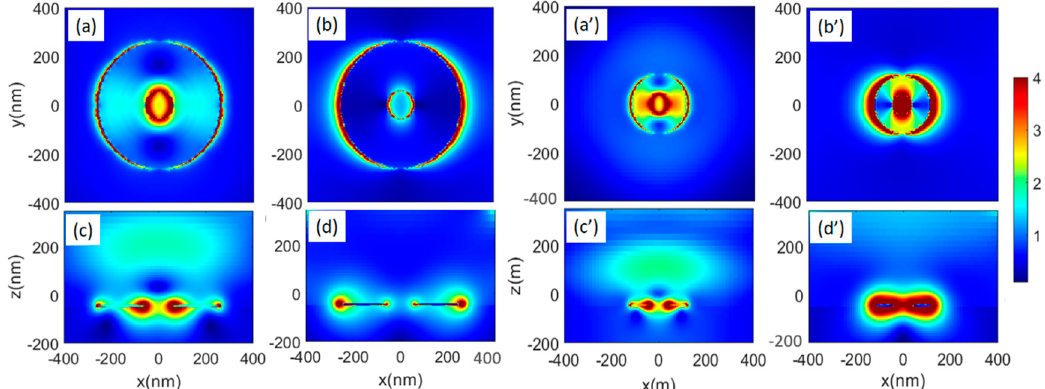
Figure 8. Mode field enhancement profiles associated with the N-donuts with D = 500 nm ( a – d ) and 240 nm ( a’ – d’ ). ( a , c ) are the profiles in the x–y and x–z planes at 814 and ( b , d ) are those at 1833 nm. ( a’ , c’ ) are profiles at 532 nm and ( b’ , d’ ) are those at 1270 nm.